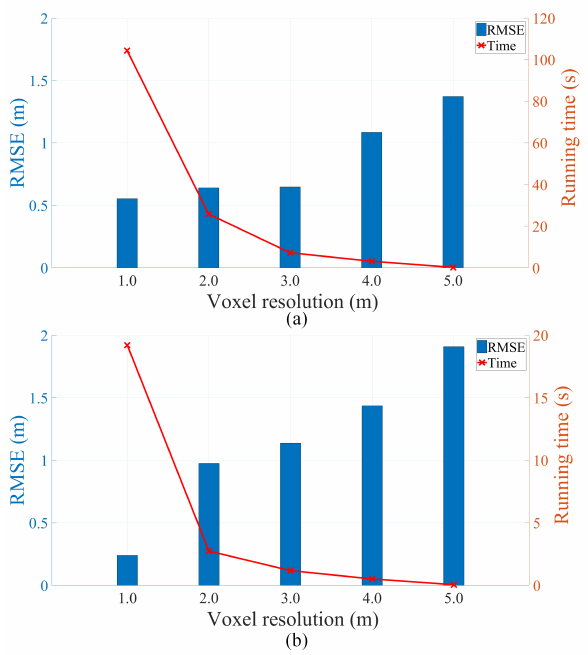
Figure 7. RMSE and running time of the tests using (a) Bremen dataset and (b) StGallen dataset with different voxel